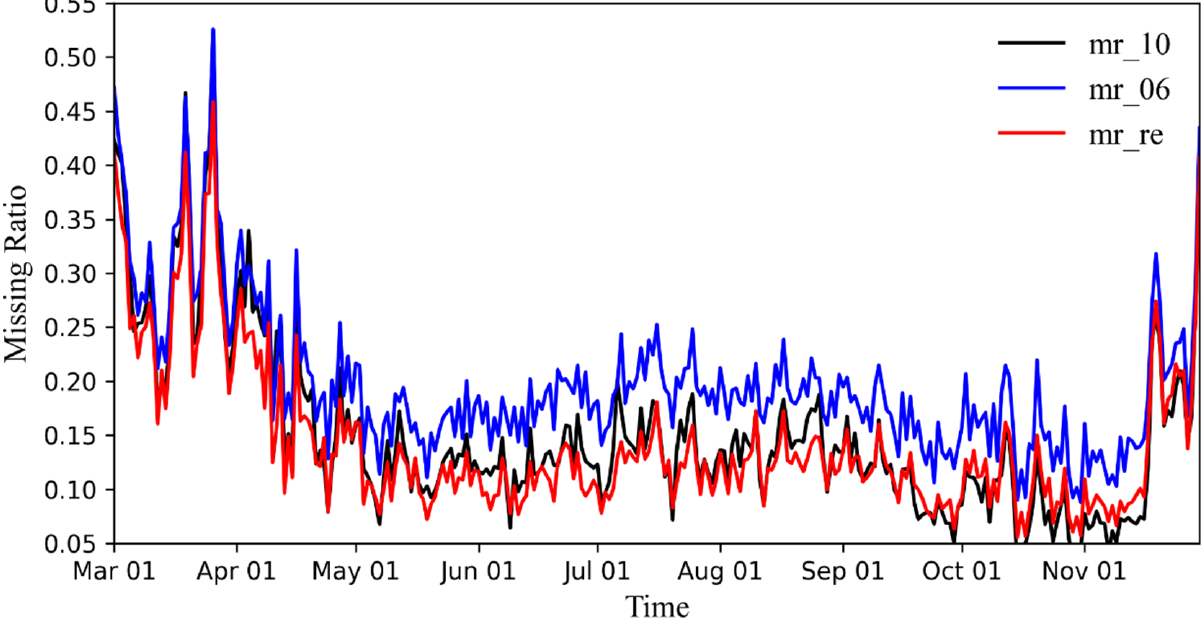
Figure 6. Daily missing rate of soil moisture retrieval for the different channels from March to November 2016. The blue curve indicates the 6 GHz results before restoration, the red curve indicates the 6 GHz results after restoration, and the black curve indicates the 10 GHz results.